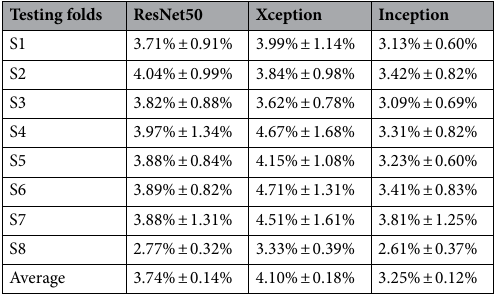
Table 3. The average loss for each model type in cross-validation for each testing